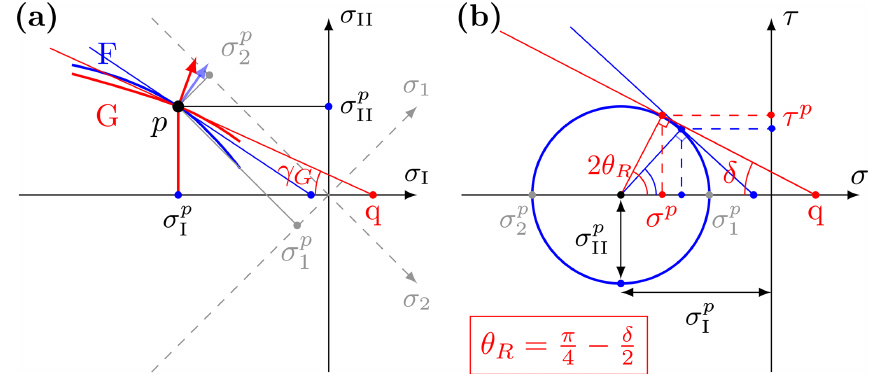
Figure 3. Link between fracture angle and yield curve: (a) arbitrary yield curve F (blue) and plastic potential G (red) in stress invariant space. The plastic potential and yield curve intersect at a stress state p for illustration purposes only. The red arrow is perpendicular to G but non-normal to the yield curve F . The tangent to the plastic potential G at point p has a slope µ G = tan (γ G ) and intersects the σ I axis at point q (thin red line). For reference, the normal and tangent to the yield curve F are shown as a thin blue arrow and line. Dashed gray lines show the principal stress axes. (b) Mohr’s circle for the fracture state p in (a) (for normal in blue and for non-normal flow rule in red) in the fracture plane of reference ( σ , τ ) of center σ p and radius σ p . The thin red line is the tangent to Mohr’s circle passing through the point q I II on the σ axis. By this geometrical construction, sin (δ) = tan (γ G ) = µ G (only valid for | µ G | ≤ 1). δ is called the dilatancy angle. Again for comparison with (a) , the blue lines and dots depicts the case of the normal flow rule (i.e., G = F ). When considering the plastic potential, the angle of fracture is written from the dilatancy angle δ as θ = π/ 4 − δ/ 2. By comparison again, δ = φ in the case of a normal flow rule and the Roscoe theory ( θ = π/ 4 − δ/ 2) reduces to the Mohr–Coulomb theory ( θ = π/ 4 − φ/ 2).